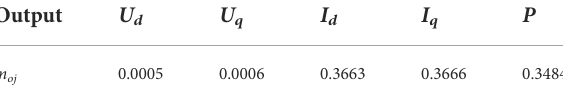
TABLE 7 The m oj of oscillation mode.